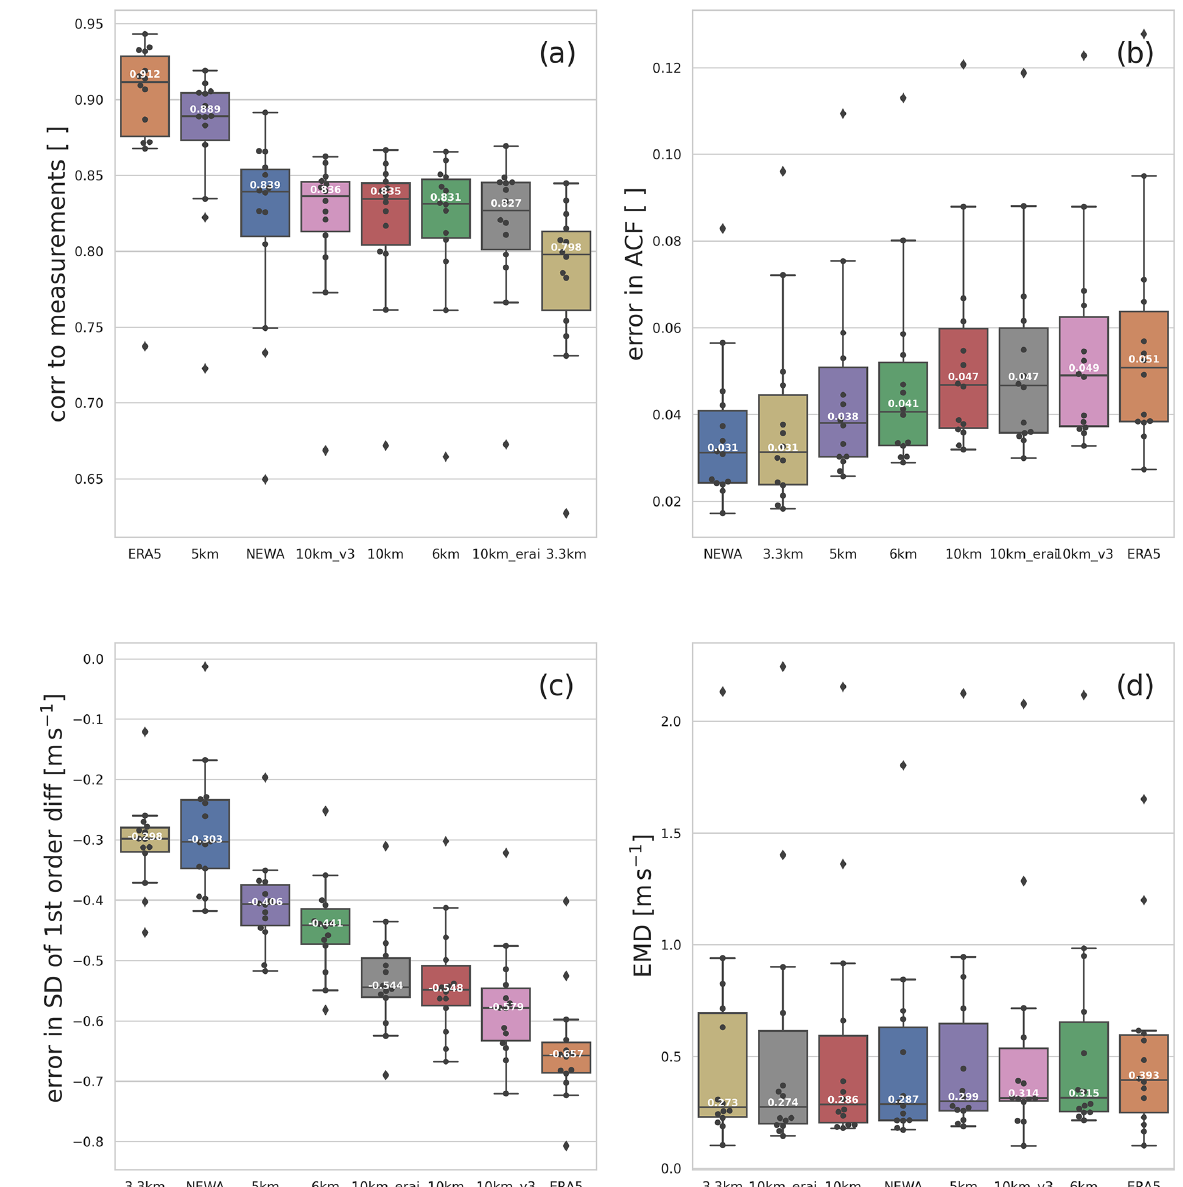
Figure 9. Boxplots of the metrics for all stations as a function of the model experiment: (a) correlations (CORR) to measurements, (b) error in the autocorrelation function (ACF), (c) error in the standard deviation (SD) of first difference, and (d) Earth mover’s distance (EMD). The model experiments are sorted as a function of their median, from the best to the